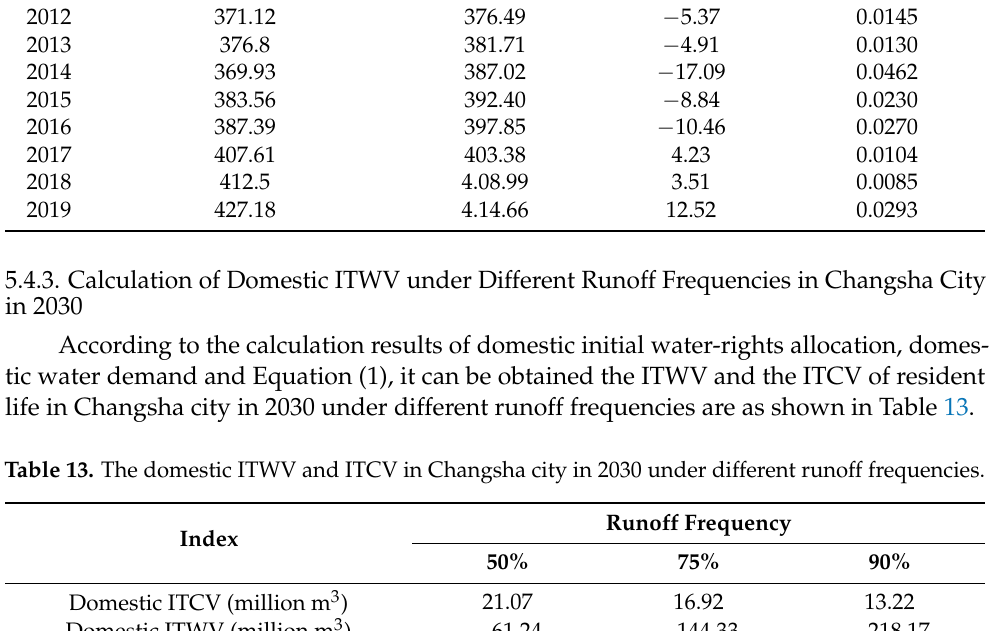
Runoff Frequency